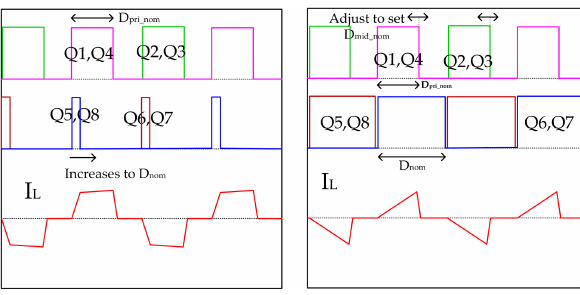
Figure 6. PWM signals plot at phase B soft-start